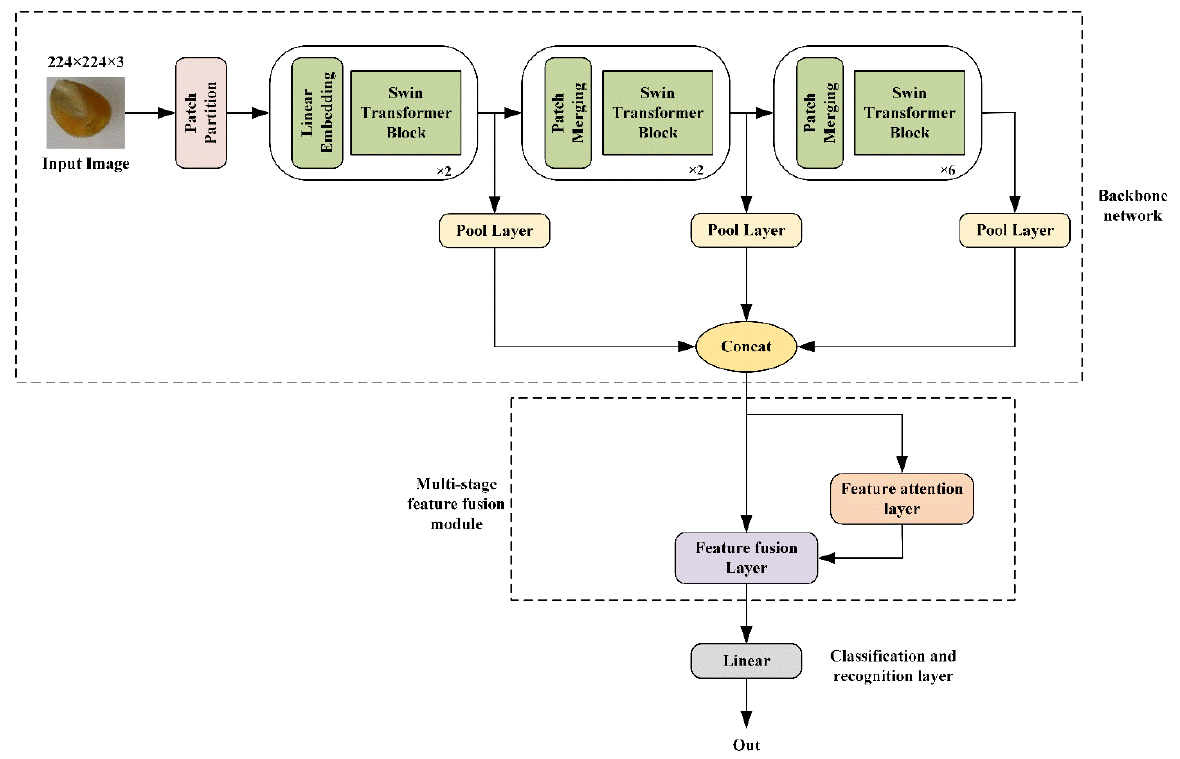
Figure 11. MFSwin- T network structure diagram.